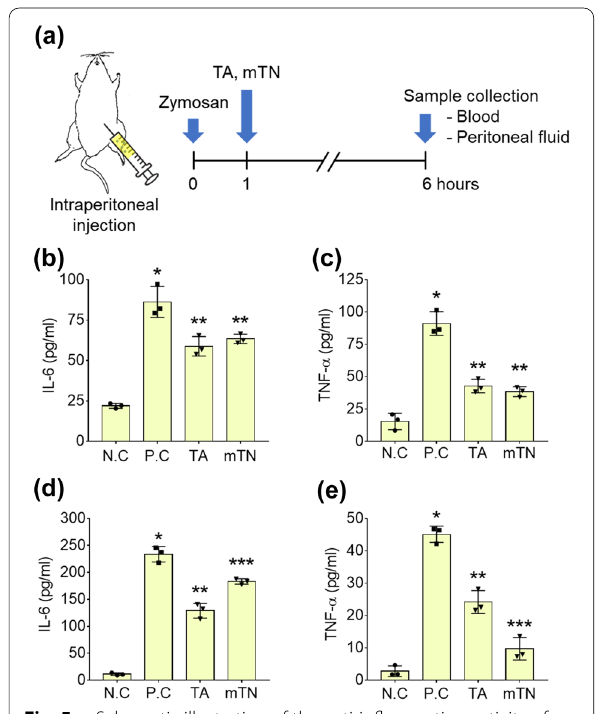
Fig. 3 a Live/dead images and b MTT assay results of hADSCs cultured using various concentrations of TA (scale bar different compared to the group with no nanoparticles ( p < 0.05). c Live/dead images and d MTT assay results of hADSCs cultured using various concentrations of mTNs (scale bar 200 μm). Significantly different compared to the group with no nanoparticles ( p < 0.05) = ∗